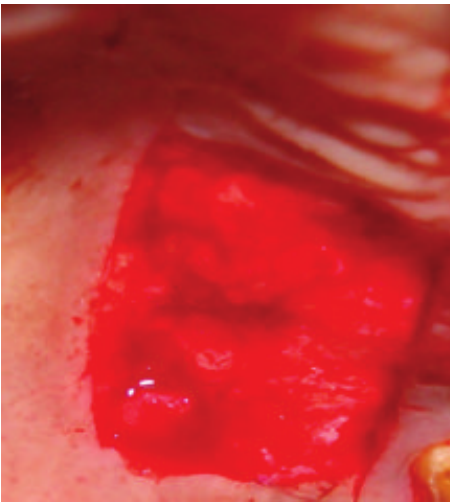
Figure 14: View of the palate after removal of the graft.